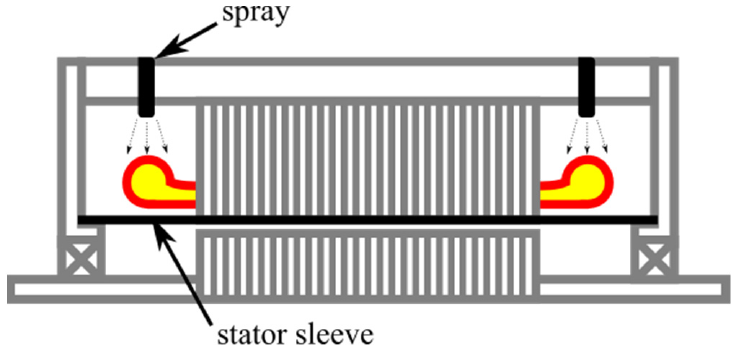
Figure 20. Spray configuration [110].